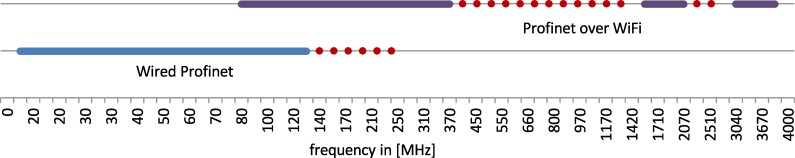
The summary of the disturbed areas in a Profinet connection.